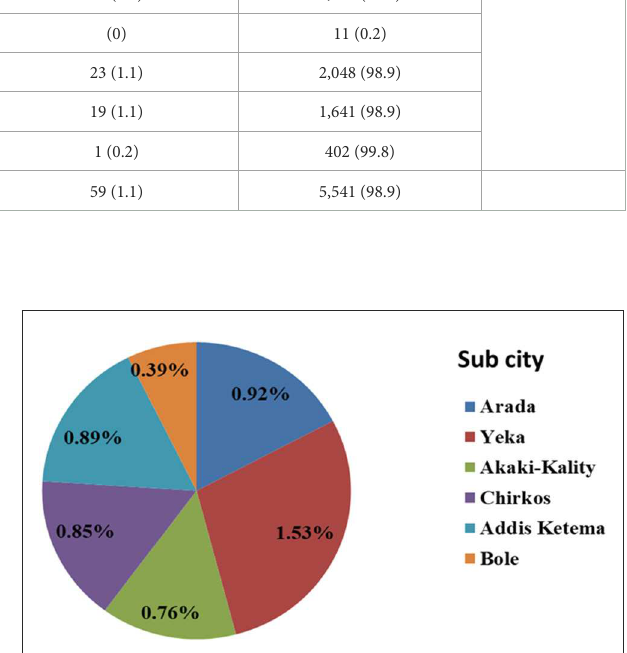
582 homeless individuals with symptoms suggestive of TB who were bacteriologically negative were treated with antibiotics for pneumonia for 2 weeks and all were